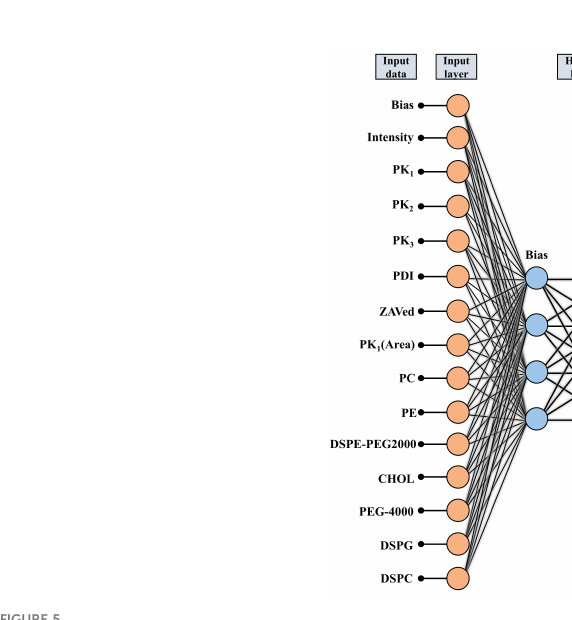
FIGURE 5 Construction of the neural network used for